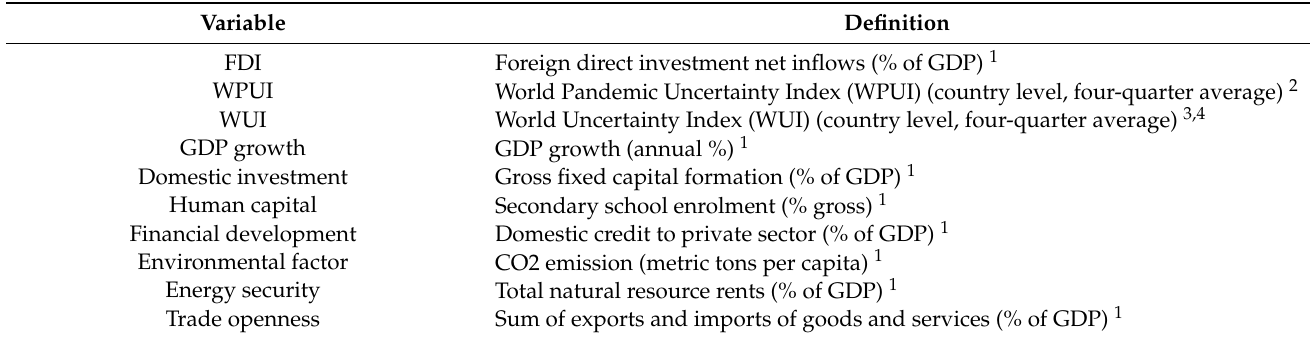
Table 1. Variable